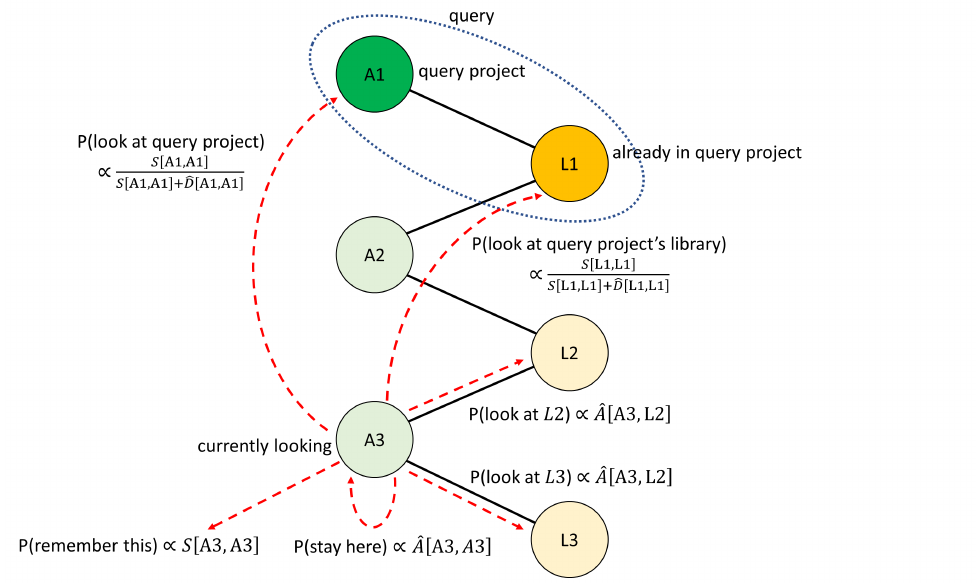
Figure 3. Random walks with memory within a project (A1,A2,A3)-library (L1,L2,L3) dependency graph. Dashed arrows represent the decisions available to developers when looking at project A3, given that they search for libraries for project A1 with known dependency